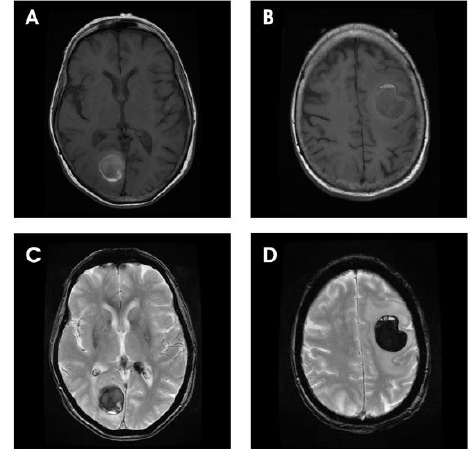
Figure 1. Axial MRI demonstrating multiple hemorrhagic lesions in a patient with metastatic melanoma. (A–B) T1 weighted images show two circumscribed lesions in the left frontal and the right occipital lobes. The mixed signal intensity within the lesion suggests the presence of hemorrhages of various chronicity. (C–D) T2* weighted sequence confirms the presence of hemorrhages as indicated by the areas of hypointensity. Additional hemorrhagic lesions are also shown in the left lateral ventricle and in the posterior third